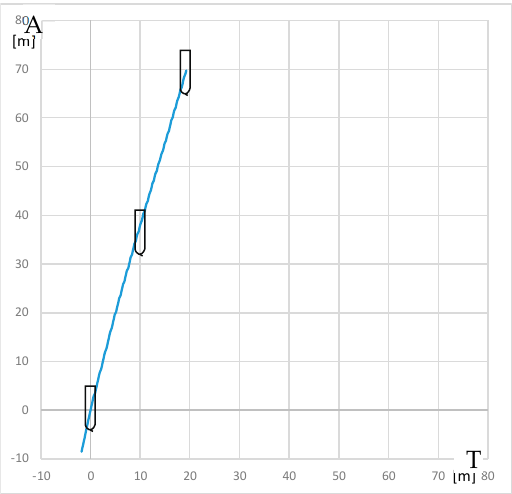
Figure 6. The trajectory of the model plotted during the steady course trial: A—advance, T—transfer. Advance and transfer are the longitudinal and transverse distances between the initial position of the point on the waterplane at the intersection of the amidships and the center plane at the beginning of the maneuver, and position of this point after completion of the